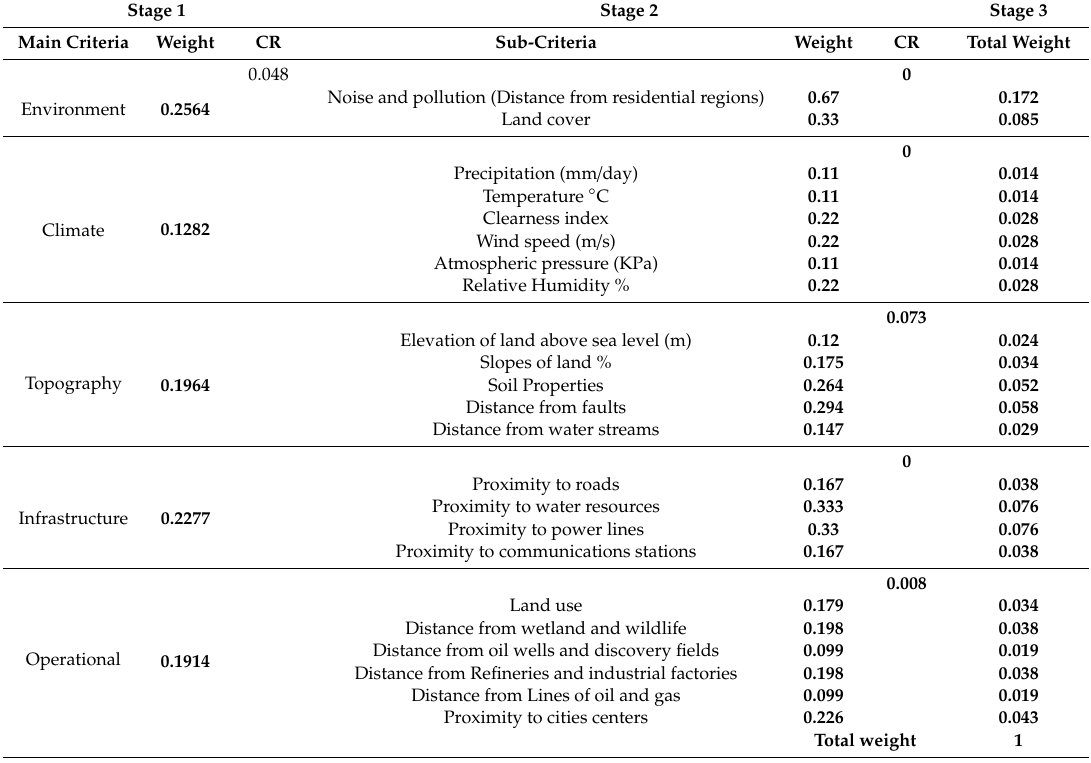
Table 13. Main criteria, sub-criteria, and their relative weights computed by using AHP method. Stage